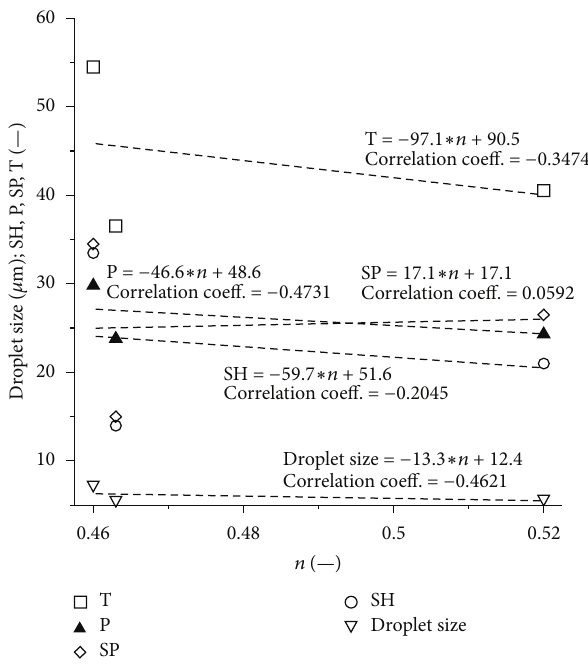
Figure 4: Relationship between sensory parameters (and droplet size) and consistency parameter 𝑘 .